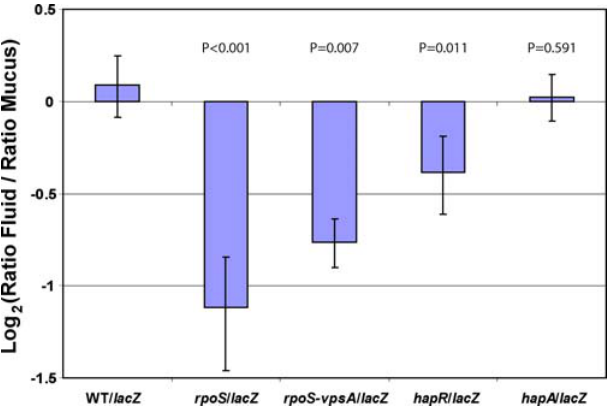
Figure 2. Distribution of Bacteria between Mucous and Luminal Fluid Quantitative localization assays in rabbit ligated ileal loops were used to compare the distribution of wild-type bacteria and different deletion mutants between the mucus and the luminal fluid. A wild-type strain with a lacZ deletion was mixed in equal numbers with the wild-type parent or the rpoS, rpoS/vpsA, hapR, or hapA deletion mutants and injected into rabbit ligated ileal loops. After 12 h of infection, the bacteria in the two compartments were isolated and the ratio between the strains in each compartment determined by plating. Log 2 to the ratio between these two values is a measure of the distribution of the mutant between the two compartments when compared with the distribution of the wild- type parent. A localization ratio less than zero indicates that the mutant strain is more numerous in the mucus fraction than in the luminal fluid fraction. Two-sample two-tailed Students t -test with a significance level of 0.05 was used to indicate a significant difference between the wild- type and the different mutants. The actual p -values are shown above the